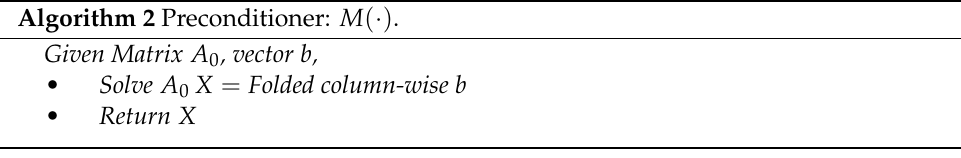
Algorithm 3 Matrix-Vector Multiply: A ( · ) .